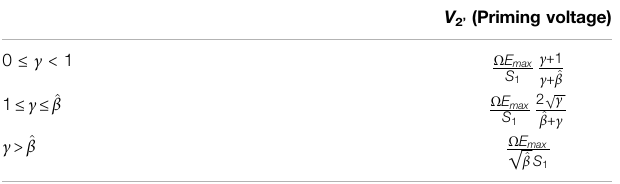
TABLE 2 | Optimal priming voltage as a function of the capacitance swing ^ β , and the relative capacitance of the storage capacitor γ = C s / C 1 .